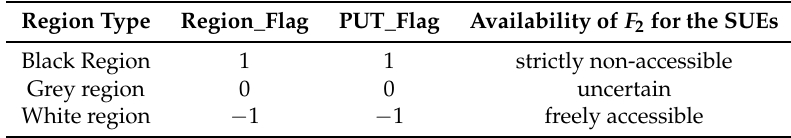
Table 1. Region oriented spectrum